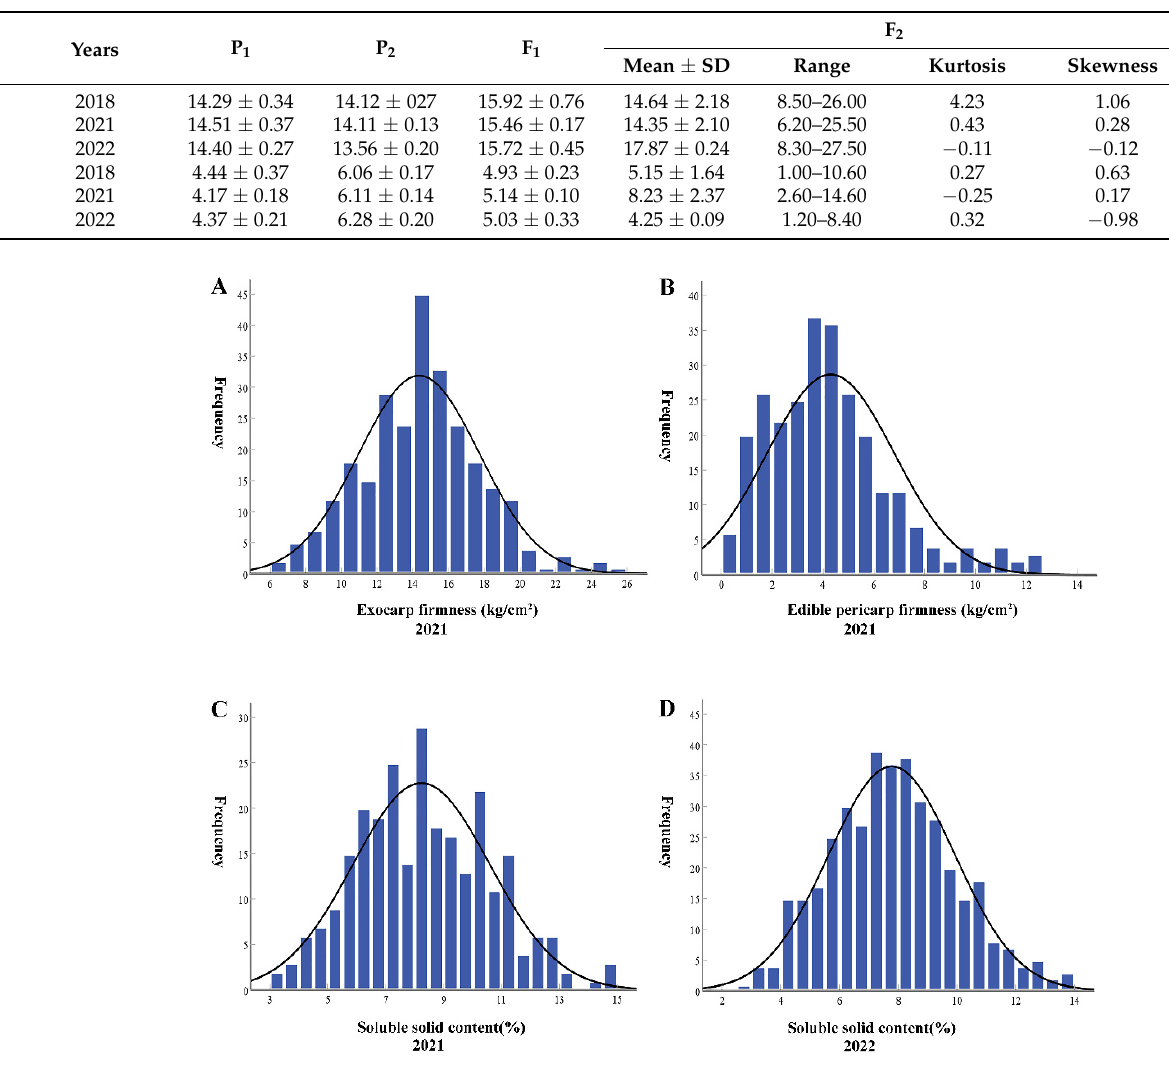
Figure 2. Distribution of EF ( A ), EPF ( B ), SSC 2021 ( C ), and SSC 2022 ( D ) frequencies in the F 2 populations.